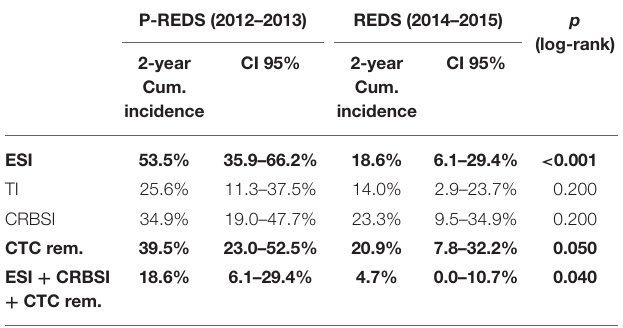
TABLE 3 | Comparison of cumulative incidence of CTC-related infectious complications in pre-REDS and REDS period of time. P-REDS (2012–2013)